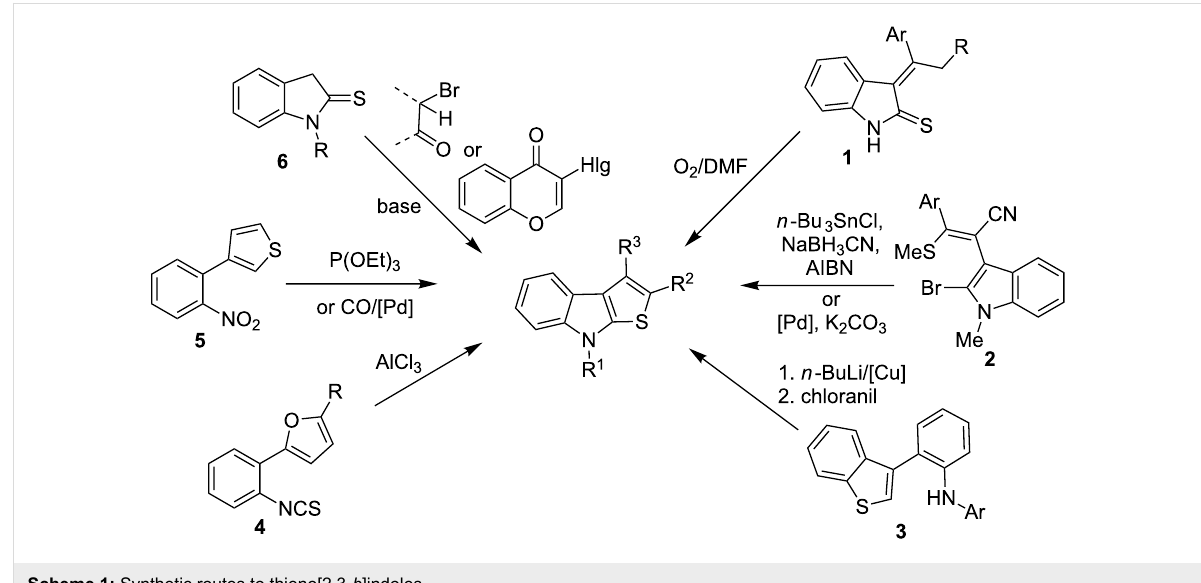
Scheme 1: Synthetic routes to thieno[2,3- b ]indoles.